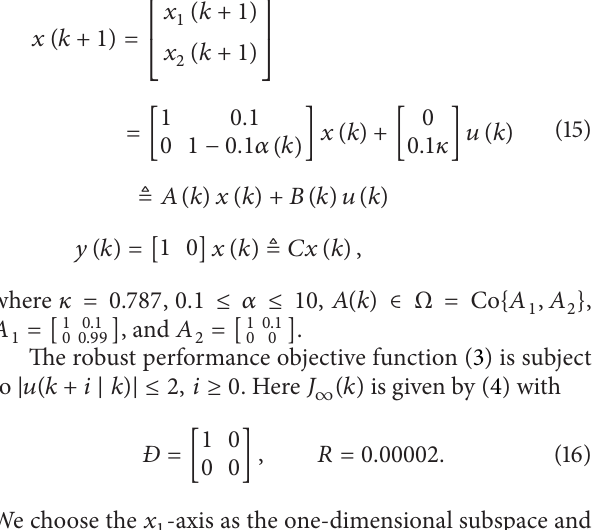
GPASE using Algorithm 5. The norm of the feedback matrix and the states are exhibited in Figures 6 and 7,